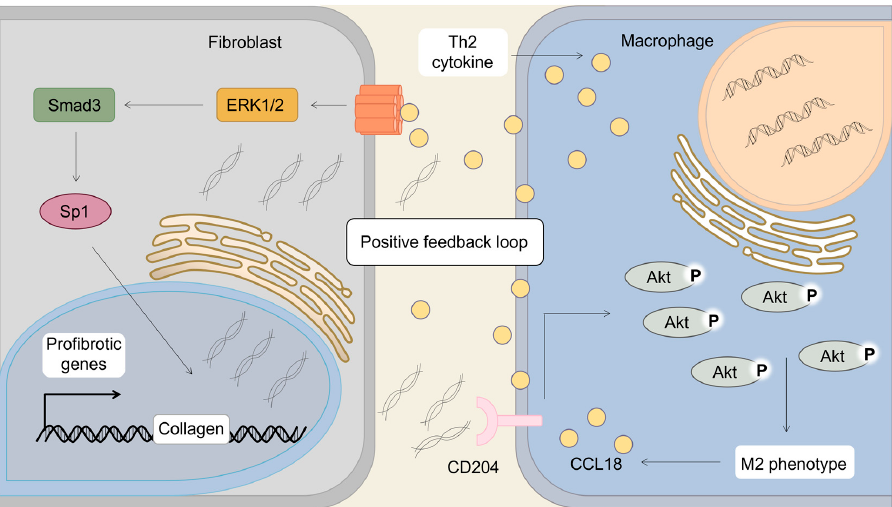
Figure 3. CCL18 mediates the vicious loop of fibroblasts and alveolar macrophages to promote lung fibrosis. CCL18 is primarily produced by alveolar macrophages in IPF. Monomeric collagen type I induces Akt phosphorylation via CD204, shifting alveolar macrophages to the alternatively activated phenotype and augmenting CCL18 production. The enhanced CCL18 interacts with receptors in fibroblasts and induces collagen production via the ERK-Smad3-Sp1 transduction axis. As the effector cells in IPF, fibroblasts form a positive feedback loop with profibrotic alveolar macrophages via CCL18 and collagen. This vicious cycle plays a significant role in